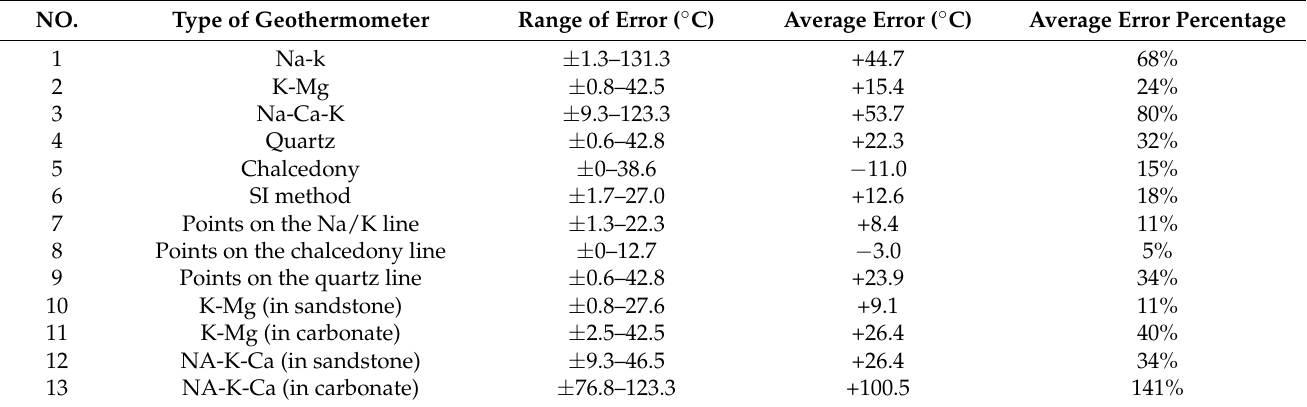
Table 3. Error values between estimated and actual temperatures for each